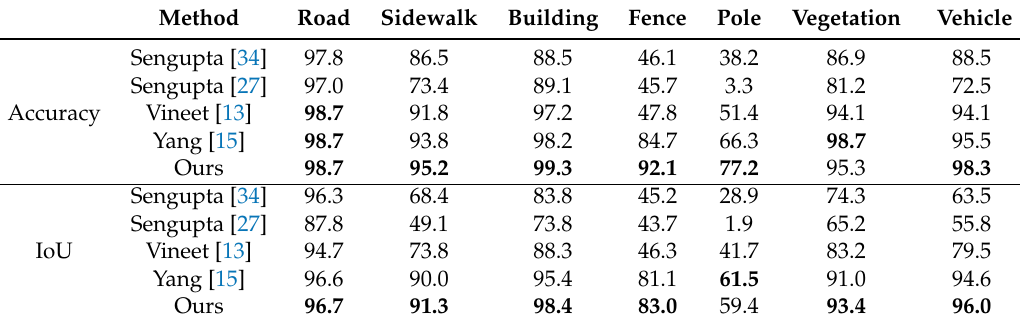
Table 1. Quantitative results for 3D semantic segmentation on the Sengupta labelled dataset. The bold fonts indicate the best